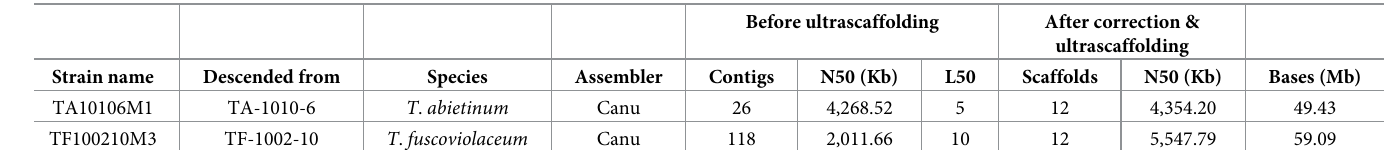
Table 1. PacBio assembly stats.